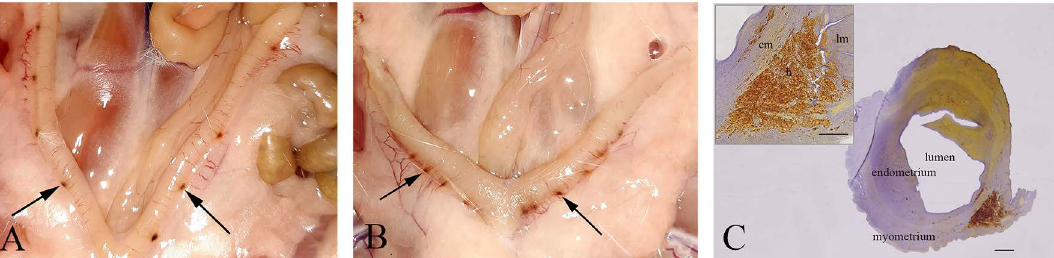
Figure 1. Embryonal resorption. ( A , B )—Pinpoint hemorrhagic placentation sites (arrows) on the uterine wall. ( C )—Cross-section of the hemorrhagic placentation sites (h); lm—longitudinal muscle cells; cm—circular muscle cells; bar = 200 µ m; insert bar = 100 µ